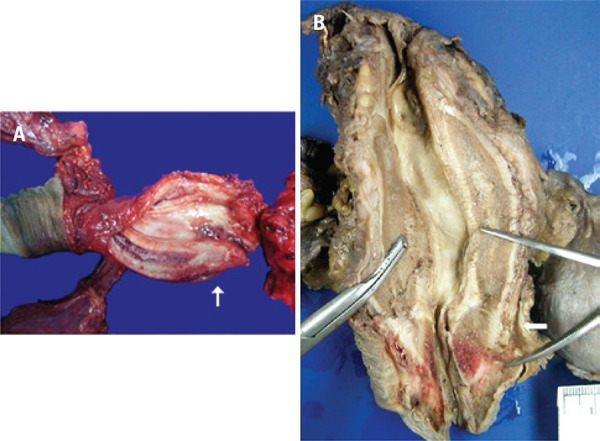
Sarcoma da uretra posterior (indicado pelas setas). Clinicamente, notavam-se espessamento e endurecimento da região acometida